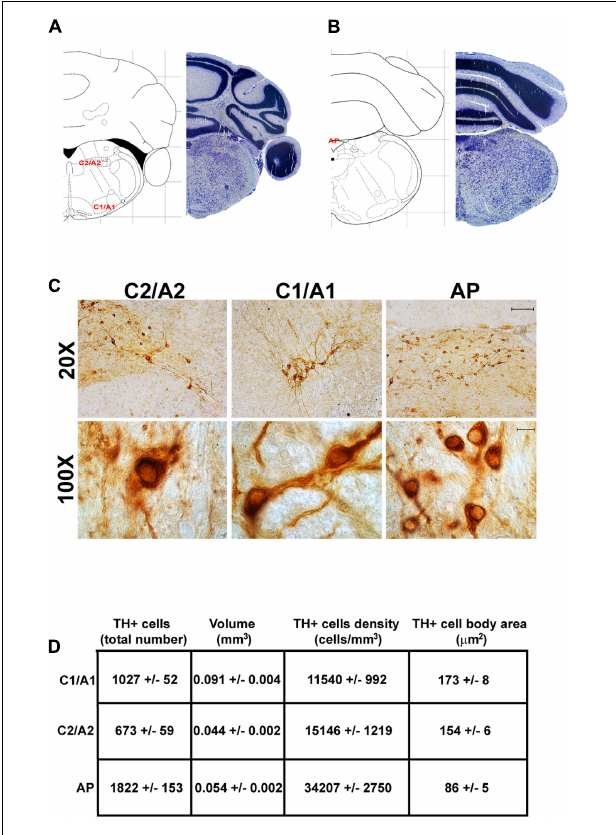
FIGURE 10 | Anatomical and morphometric analyses of TH-positive cell of the C1/A1, C2/A2, and AP catecholaminergic nuclei. Nissl staining of the mouse brain at the Bregma level –6.36 (A) and –7.32 (B) (Paxinos and Franklin, 2001) showing the anatomical localization of C1/A1, C2/A2, and AP catecholaminergic groups. (C) Representative images of TH immunoreactive cells of the C1/A1, C2/A2, and AP. Images at higher magnification (100X) show the morphological features of these TH positive cells. Scale bar: 100 µ m for 20X and 10 µ m for 100X. The corresponding morphometric analyses are shown in (D) . Values are means ±